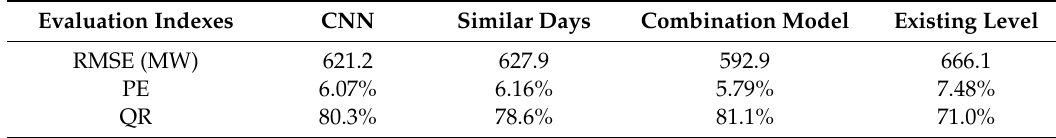
Table 5. Forecast indicators for the whole year of